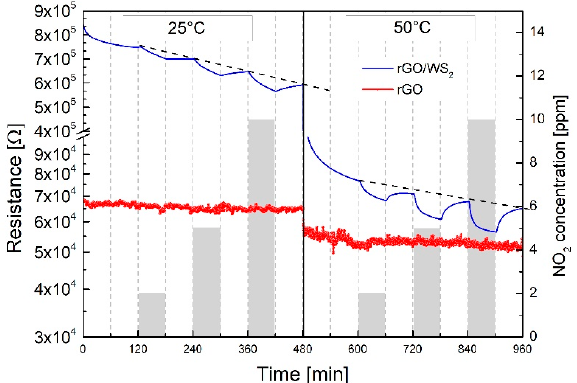
Figure 5. Electrical responses of single rGO (red line) and WS 2 -decorated rGO films (blue line) in dry air and NO 2 concentrations in the range 2–10 ppm at 25 °C and 50 °C operating temperature.